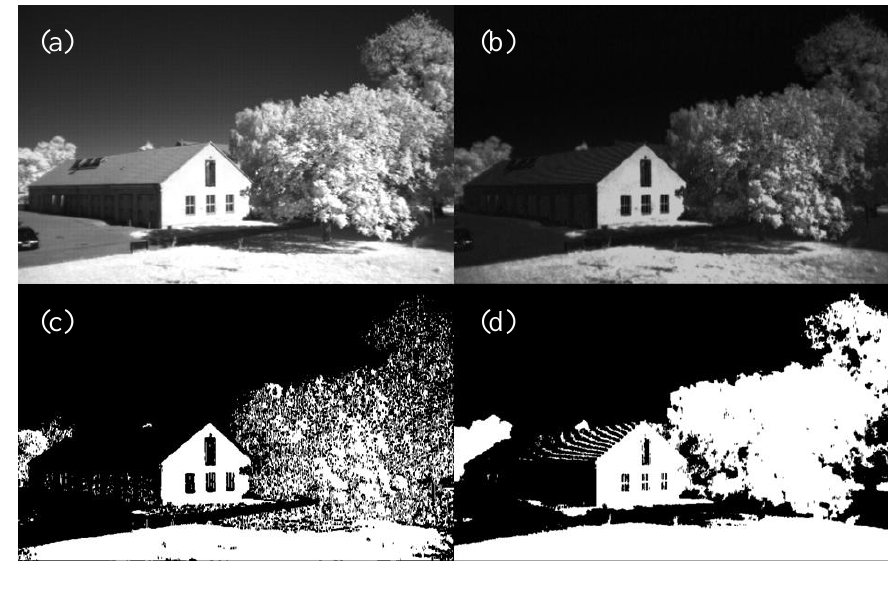
Figure 15. ( a ) Raw image of a landscape under direct sunlight condition, ( b ) reNDVI image, ( c ) binary image for the NDVI and ( d ) binary image for the reNDVI binary images are five-point Gaussian filtered